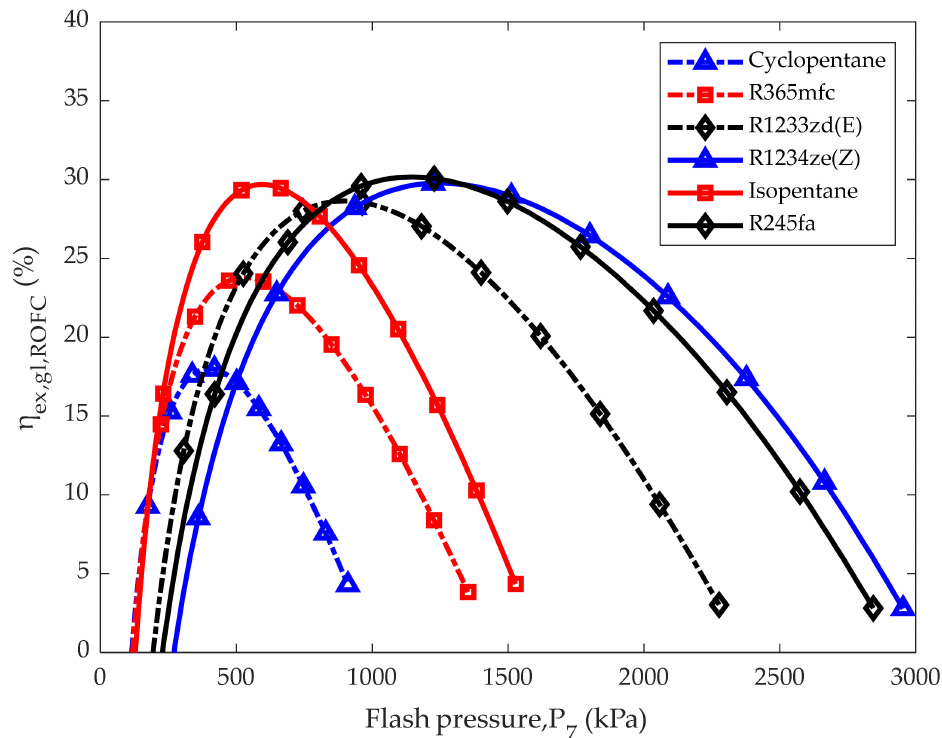
Figure 5. Effect of flash pressure on the global exergy